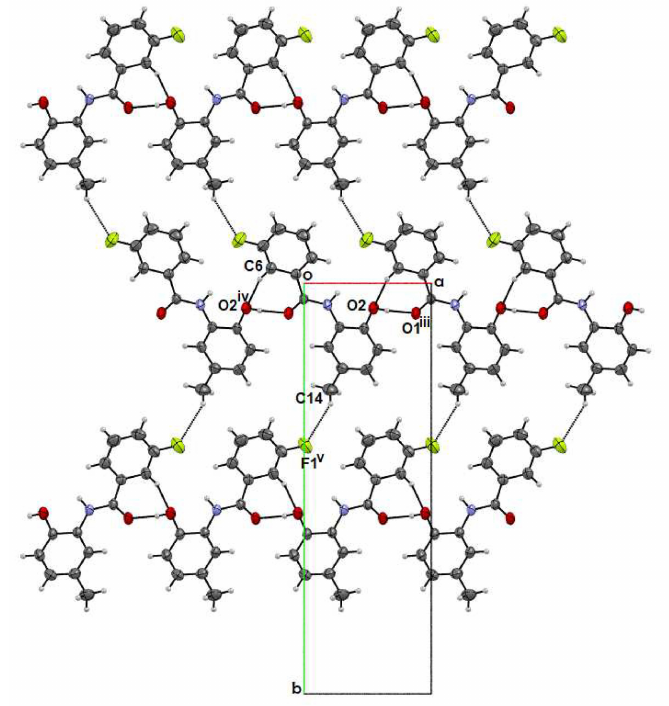
Figure 3. Crystal packing of m -FPhB seen along